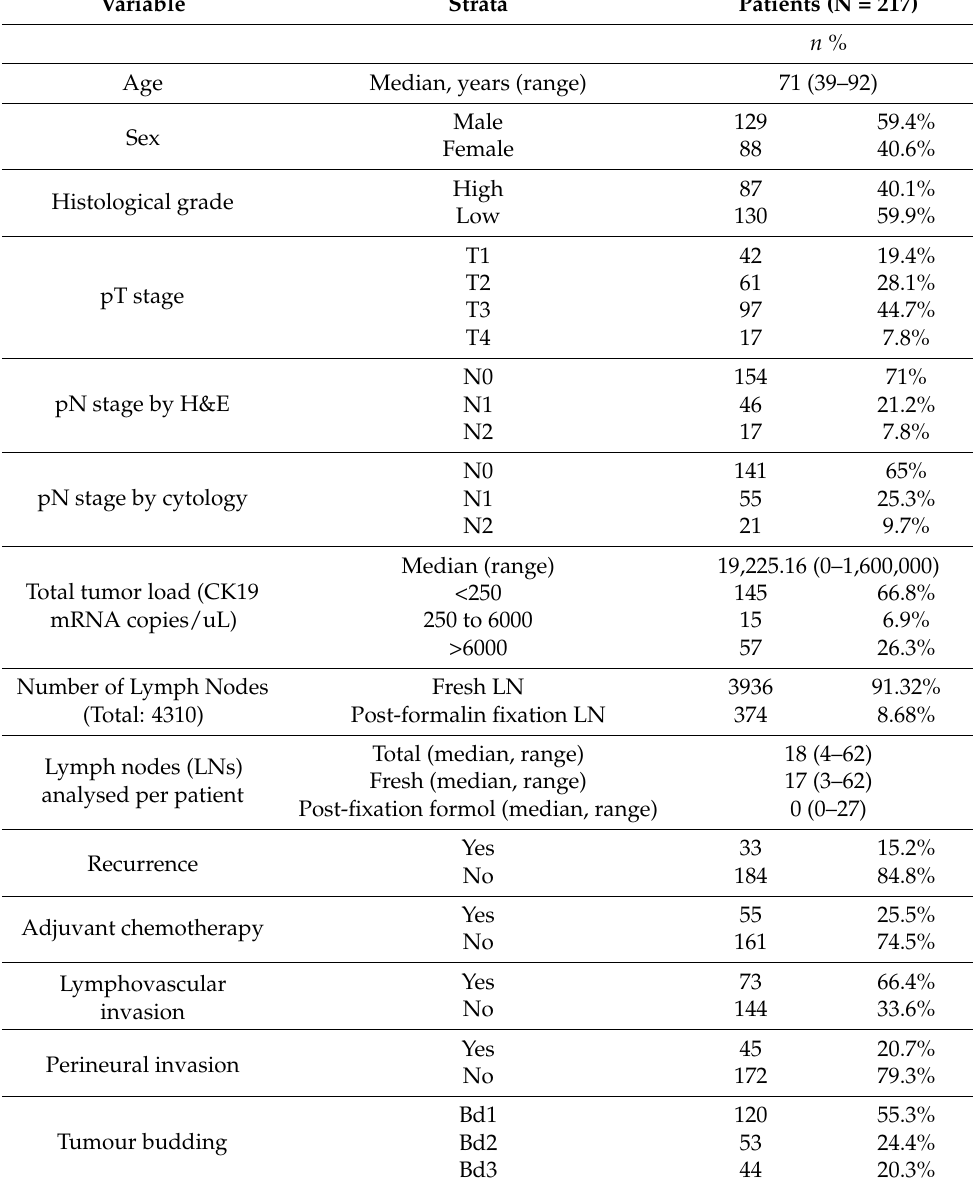
Table 1. Clinical and pathological characteristics of the study